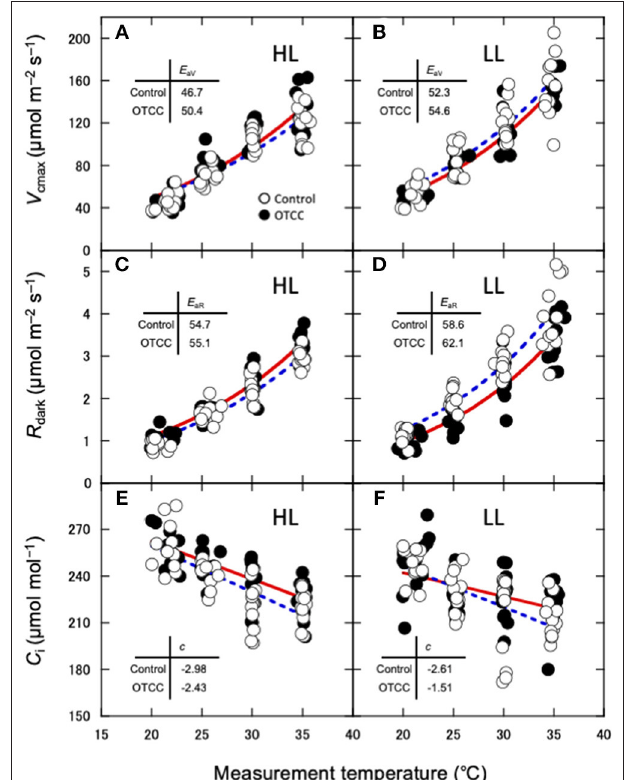
FIGURE 3 | Temperature dependence of the apparent maximum carboxylation rate ( V cmax ) (A,B) , dark respiration rate ( R dark ) (C,D) and interceller CO 2 concentration (E,F) in canopy leaves of Quercus serrata at high ( A,C,E ; HL) and low ( B,D,F ; LL) latitude sites. Measurements were made in August 2012. Leaves were exposed to either naturally changing temperature conditions (control; open circles with broken line) or experimental warming with open-top chambers (OTCC; closed circles with solid line). E aV , activation energy of V cmax (kJ mol − 1 ); E aR , activation energy of R dark (kJ mol − 1 ); c , temperature dependence of C i . a, c and e are redrawn from Yamaguchi et al. (2016) with